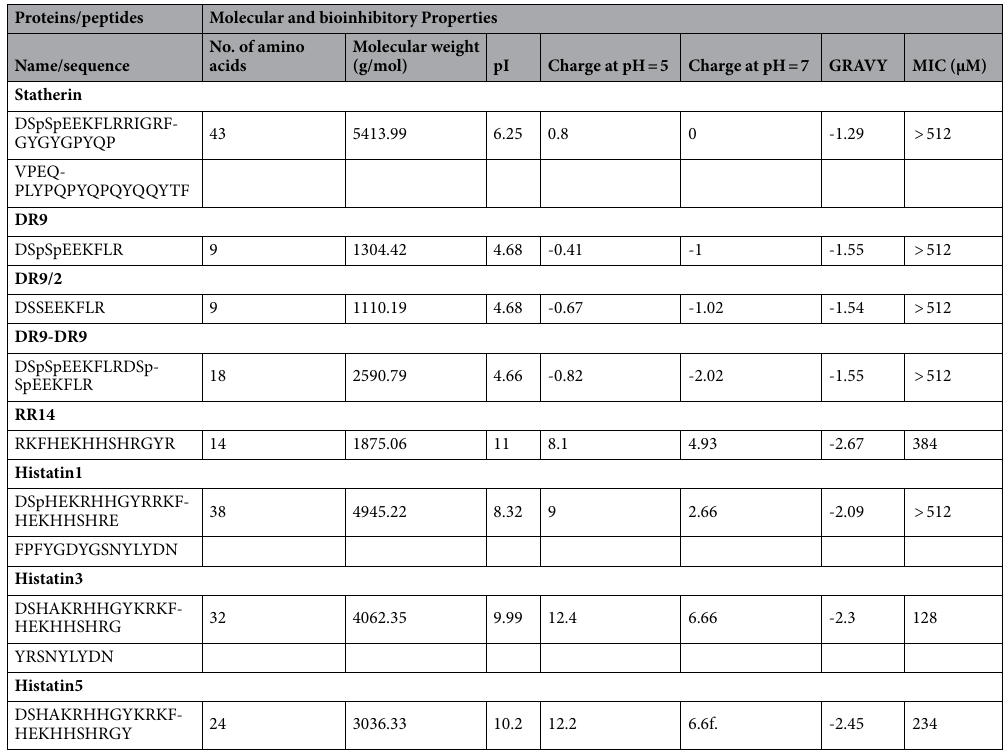
Table 1. Tested proteins/peptides and their molecular and bioinhibitory properties. Molecular properties obtained from https:// web. expasy. org/ protp aram/ and http:// www. baamps. it/. The red amino acids in the sequences of proteins/peptides symbolize the phosphorylated serine residues. “pI” denotes the isoelectrical point; the pH at which the molecule carries no net electrical charge. GRAVY stands for grand average of hydropathy. The GRAVY value for protein/peptide is calculated as the sum of hydropathy values/ hydrophobicity of all the amino acids, divided by the number of residues in the sequence. Minimum Inhibitory Concentrations (MICs) were determined against Streptococcus mutans U159 in micromolar